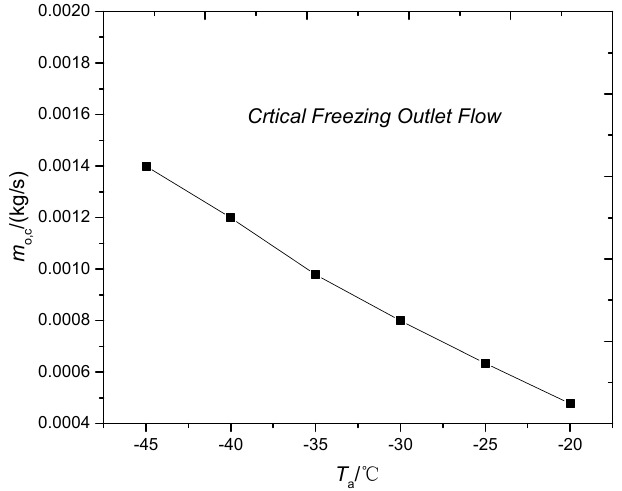
Figure 10. Critical freezing outlet flow versus ambient temperature.